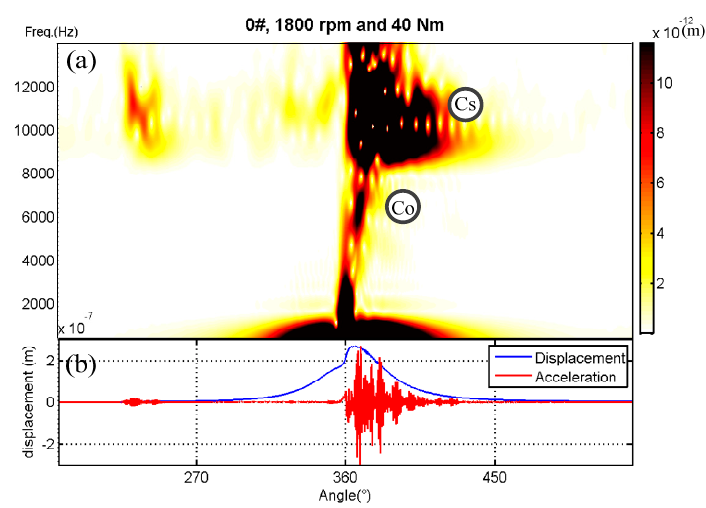
Figure 11. Short-time Fourier transform (STFT) of predicted displacement response to combustion under 40 Nm and 1800 rpm; ( a ) STFT result of predicted displacement response; ( b ) Predicted displacement and acceleration responses.